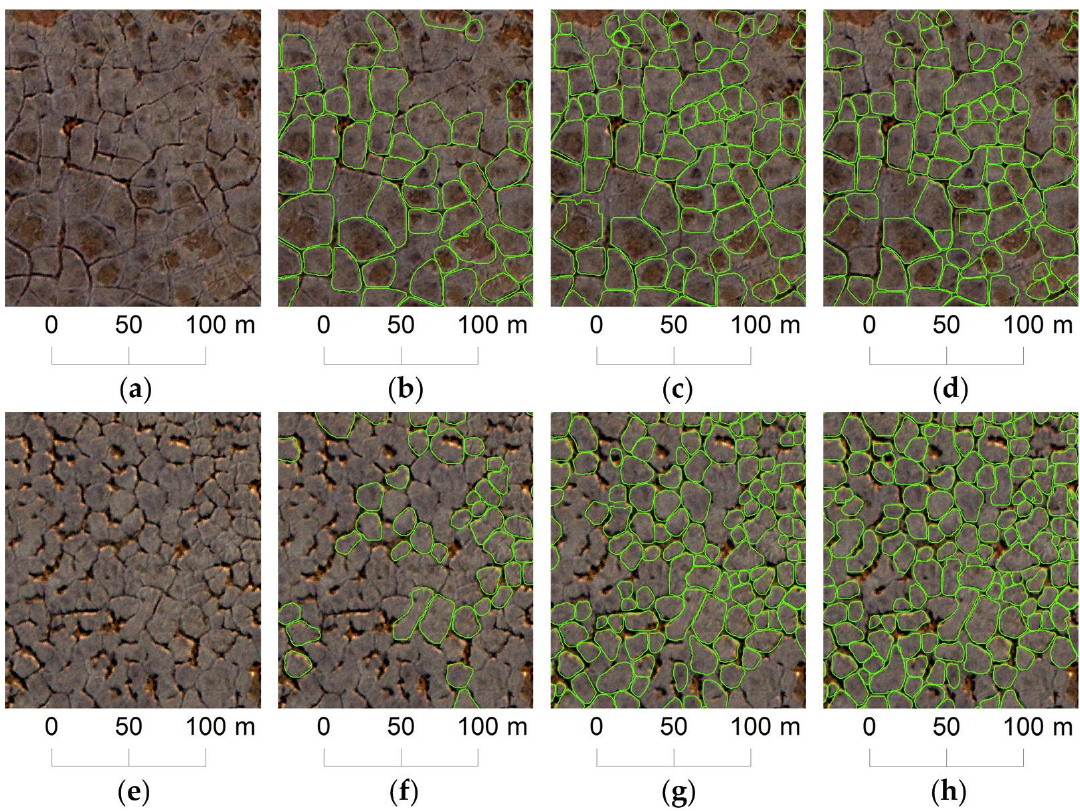
Figure 5. Examples of results of the IWP detection and delineation using the high-resolution satellite image. Enlarged portions of the satellite image ( a , e ); mapped IWPs from ( a ) with green boundaries of IWPs delineated by the Mask R-CNN models used in the C1, C2, and C3 case studies ( b , c , d ); mapped IWPs from ( e ) with green boundaries of IWPs delineated by the Mask R-CNN models used in the C1, C2, and C3 case studies ( f , g , h ). Imagery © [2015] DigitalGlobe, Inc.